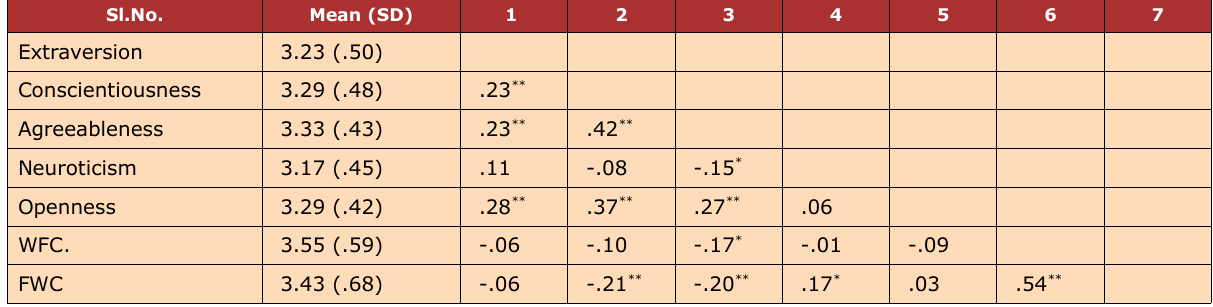
Table 2. Showing the mean, standard deviation and inter